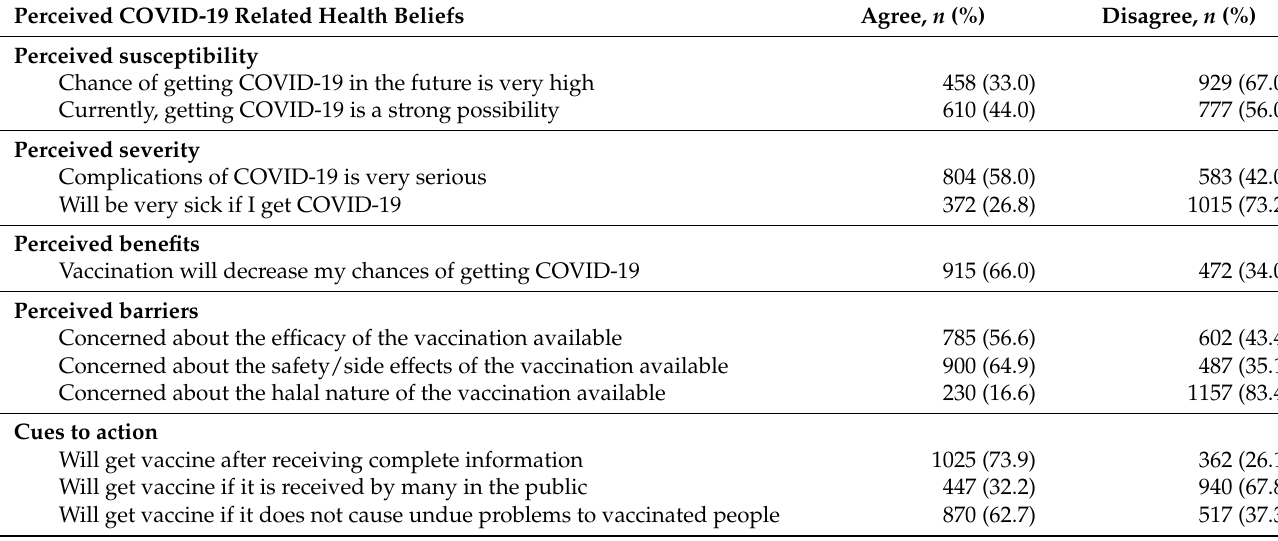
Table 2. COVID-19 related health beliefs in the KSA, February–March 2021.